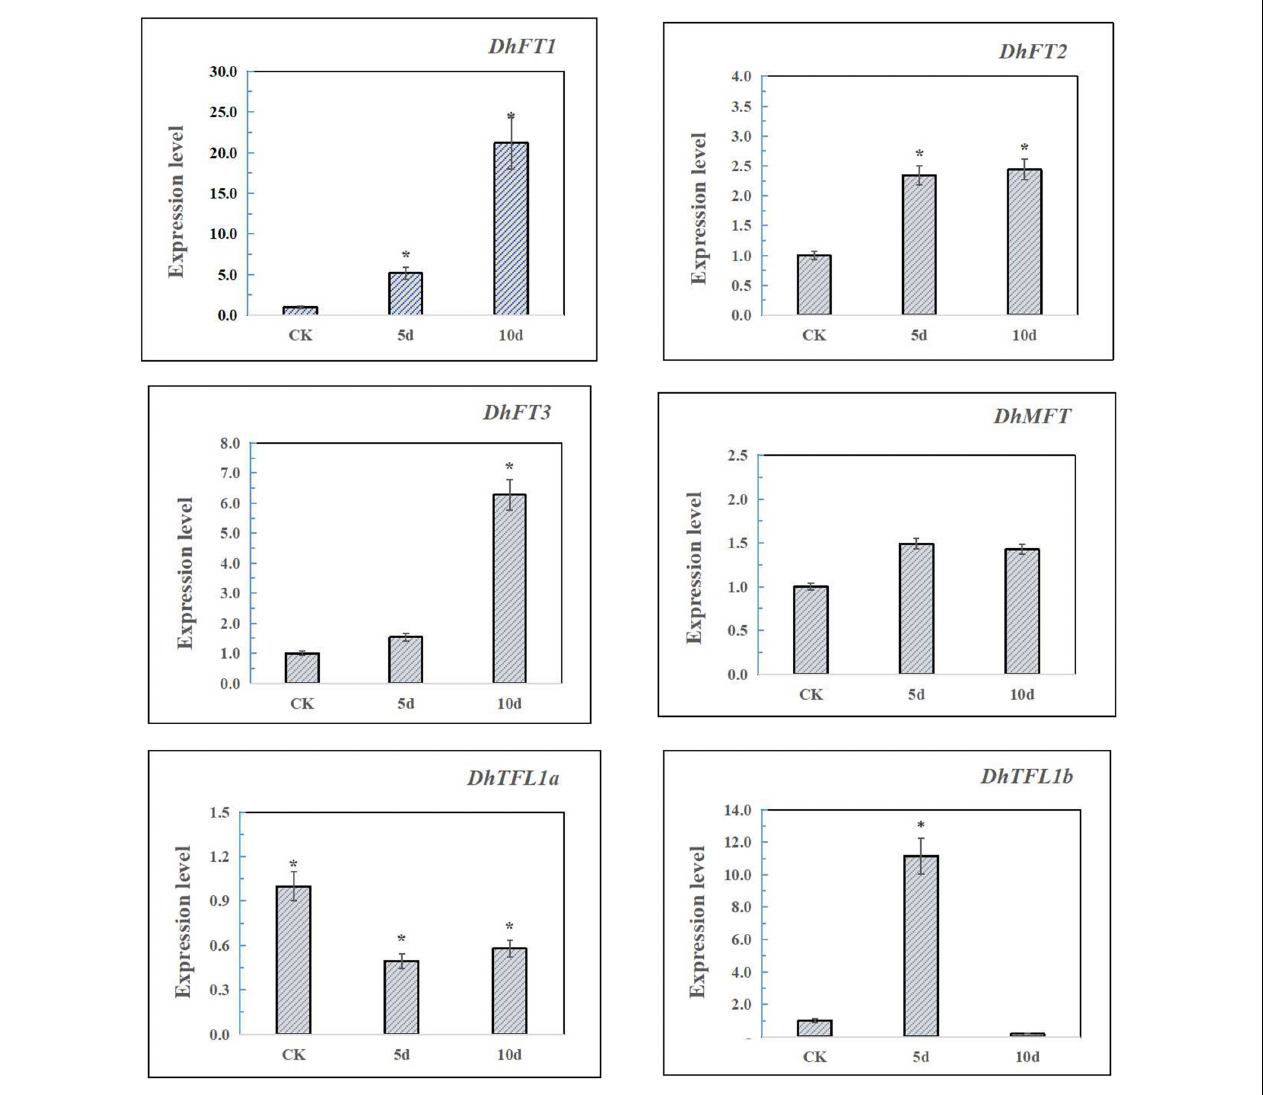
FIGURE 8 | The qRT-PCR analysis of DhPEBPs . Asterisks mean that the expression levels have significant differences compared with CK.